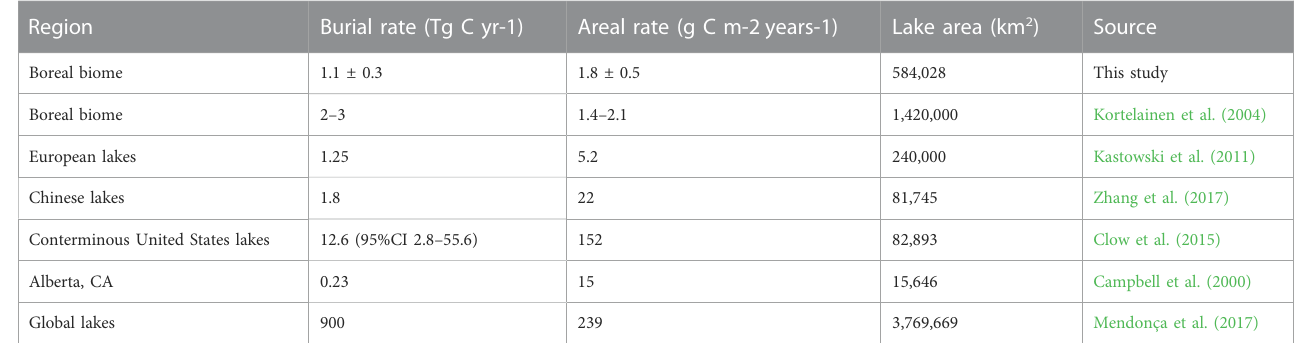
TABLE 2 Comparison of large-scaleestimates of carbonburial rates. It should be noted that such estimates come from descriptive studies which inevitablyhave biases in data collection and uncertainty in measurements and calculations due to the logistical constraints of bottom-up scaling.